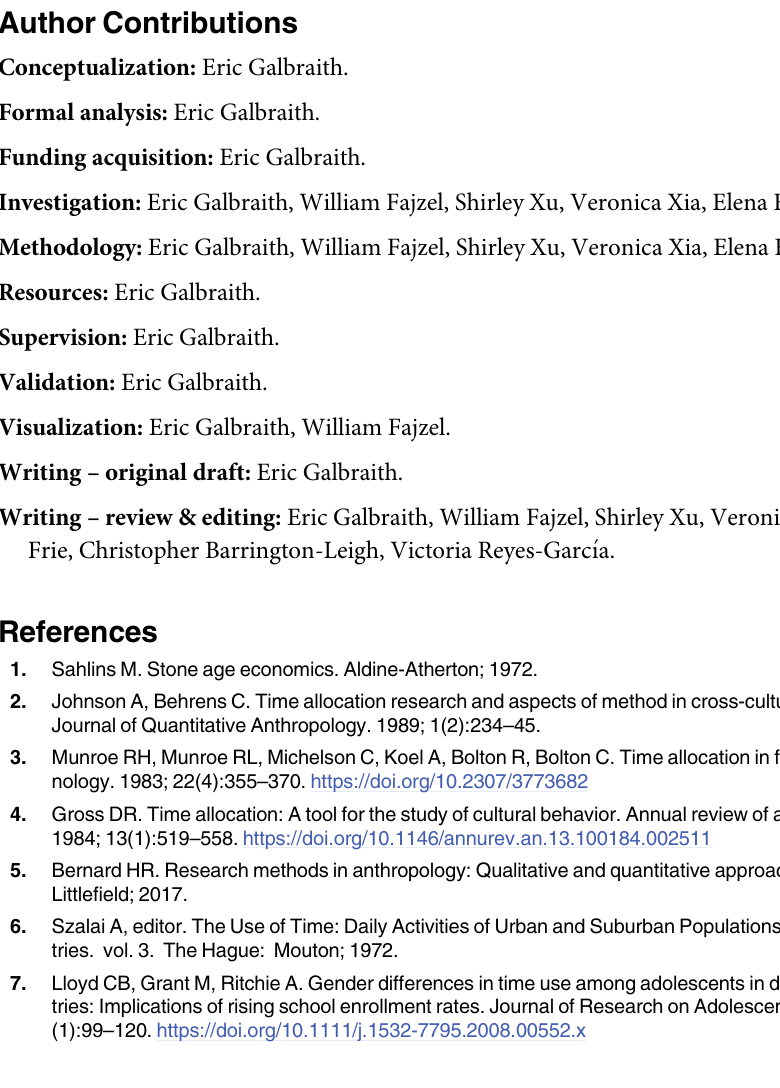
S4 Fig. Association of MOOGAL categories with ICATUS activities, part two. Squares indi- cate the cross-mapping of hunter-gatherer activities to categories. Darkest shades indicate that an activity is entirely associated with a single MOOGAL category, paler shades indicate that the activity is distributed across multiple MOOGAL